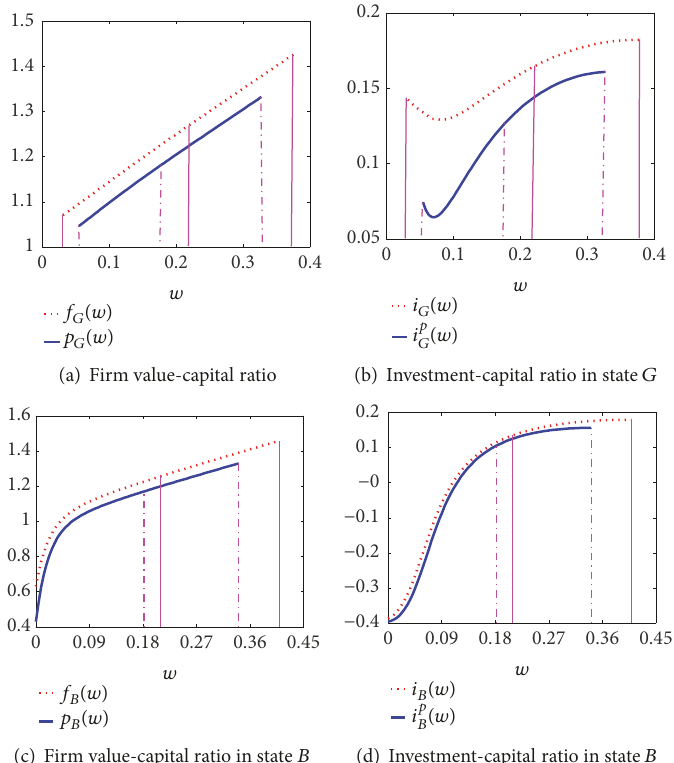
Figure 4: Firm value-capital ratio and investment-capital ratio for two preferences in a regime switching